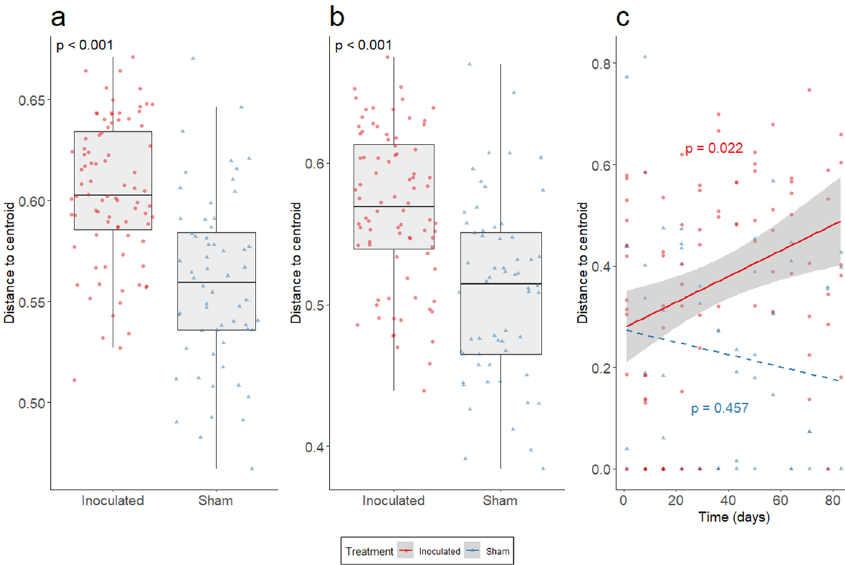
Figure 3. Inoculation results in higher β-diversity of the host microbiome. Multivariate dispersion of the host microbiome was approximated by generating distance-to-centroid values for the ( a ) Jaccard, ( b ) Bray–Curtis, and ( c ) Raup-Crick dissimilarity metrics. ( a , b ) There was a significant difference between treatment groups for both the Jaccard and Bray–Curtis indices (boxplots; LME p -values within each panel). Inoculated snakes were predicted to have higher distance-to-centroid values indicating greater dissimilarity or β-diversity throughout the experiment. ( c ) A positive relationship was observed between time and distance-to-centroid values for the Raup-Crick metric in the inoculated treatment group. Thus, the host microbiome of inoculated snakes tended to become more dissimilar over time. No relationship between time and distance-to-centroid values was found for the Raup-Crick metric for the sham control group. Consequently, a dotted line was used to represent the regression for this group ( p -values are provided for post-hoc regressions).